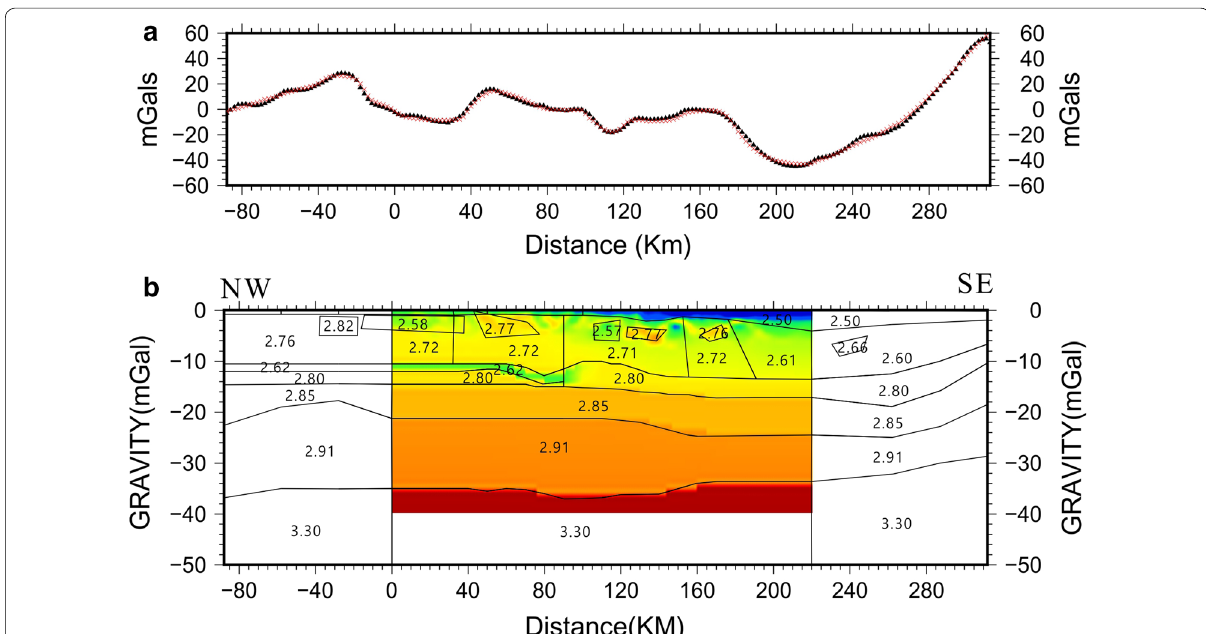
Fig. 11 Poisson’s ratio along the Line 1 seismic profile. The red line indicates the reflection boundaries used in the inversion. The red stars indicate the shotpoints (SP). The white dash lines indicate the limits of the seismic ray coverage for the inversion of P-wave and S-wave velocity model. Poisson’s ratio in the crystalline crust varies predominately from 0.24 to